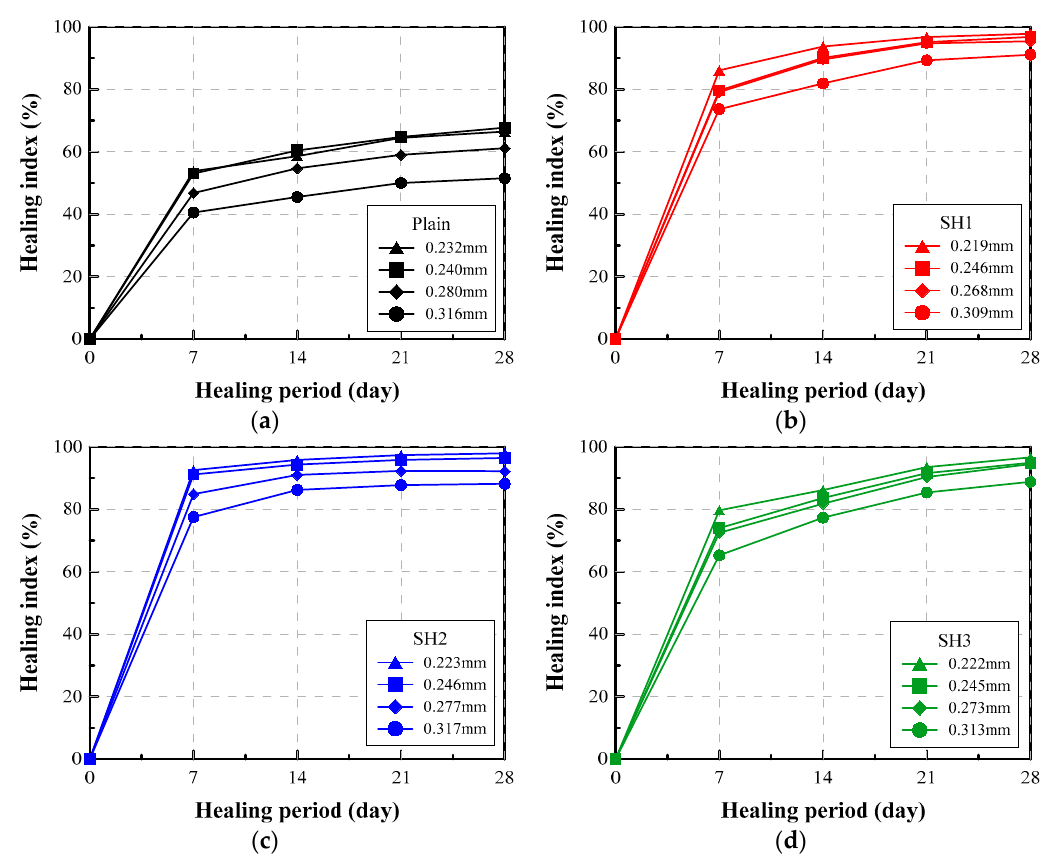
Figure 8. Healing index vs. healing period of selected specimens: ( a ) Plain, ( b ) SH1, ( c ) SH2, ( d ) SH3. For further investigation, the relationships between the healing index and the initial crack width are shown in Figure 9. It shows the healing index at a certain time is highly related to the initial crack width. The correlation coefficients between the crack width and the healing index are calculated to be at least 0.92 and on average 0.96, so that the relationship can be expressed as a linear equation through the regression analysis, as shown in Figure 9. The equation clearly shows the potential self-healing performance of the mixtures. For example, if the expected initial crack was 0.25 mm, then the expected healing performance of the Plain, SH1, SH2, and SH3 mixtures after 28 days would be 0.65, 0.95, 0.95, and 0.96, respectively. Alternatively, if the targeted healing index is 0.90 at 28 days, then the maximum allowable initial crack width that can be healed would be calculated to be 0.10, 0.30, 0.32, and 0.33 mm for the Plain, SH1, SH2, and SH3 mixtures, respectively. In this way, this equation could be used before the use of self-healing materials to confirm the expected possible healing